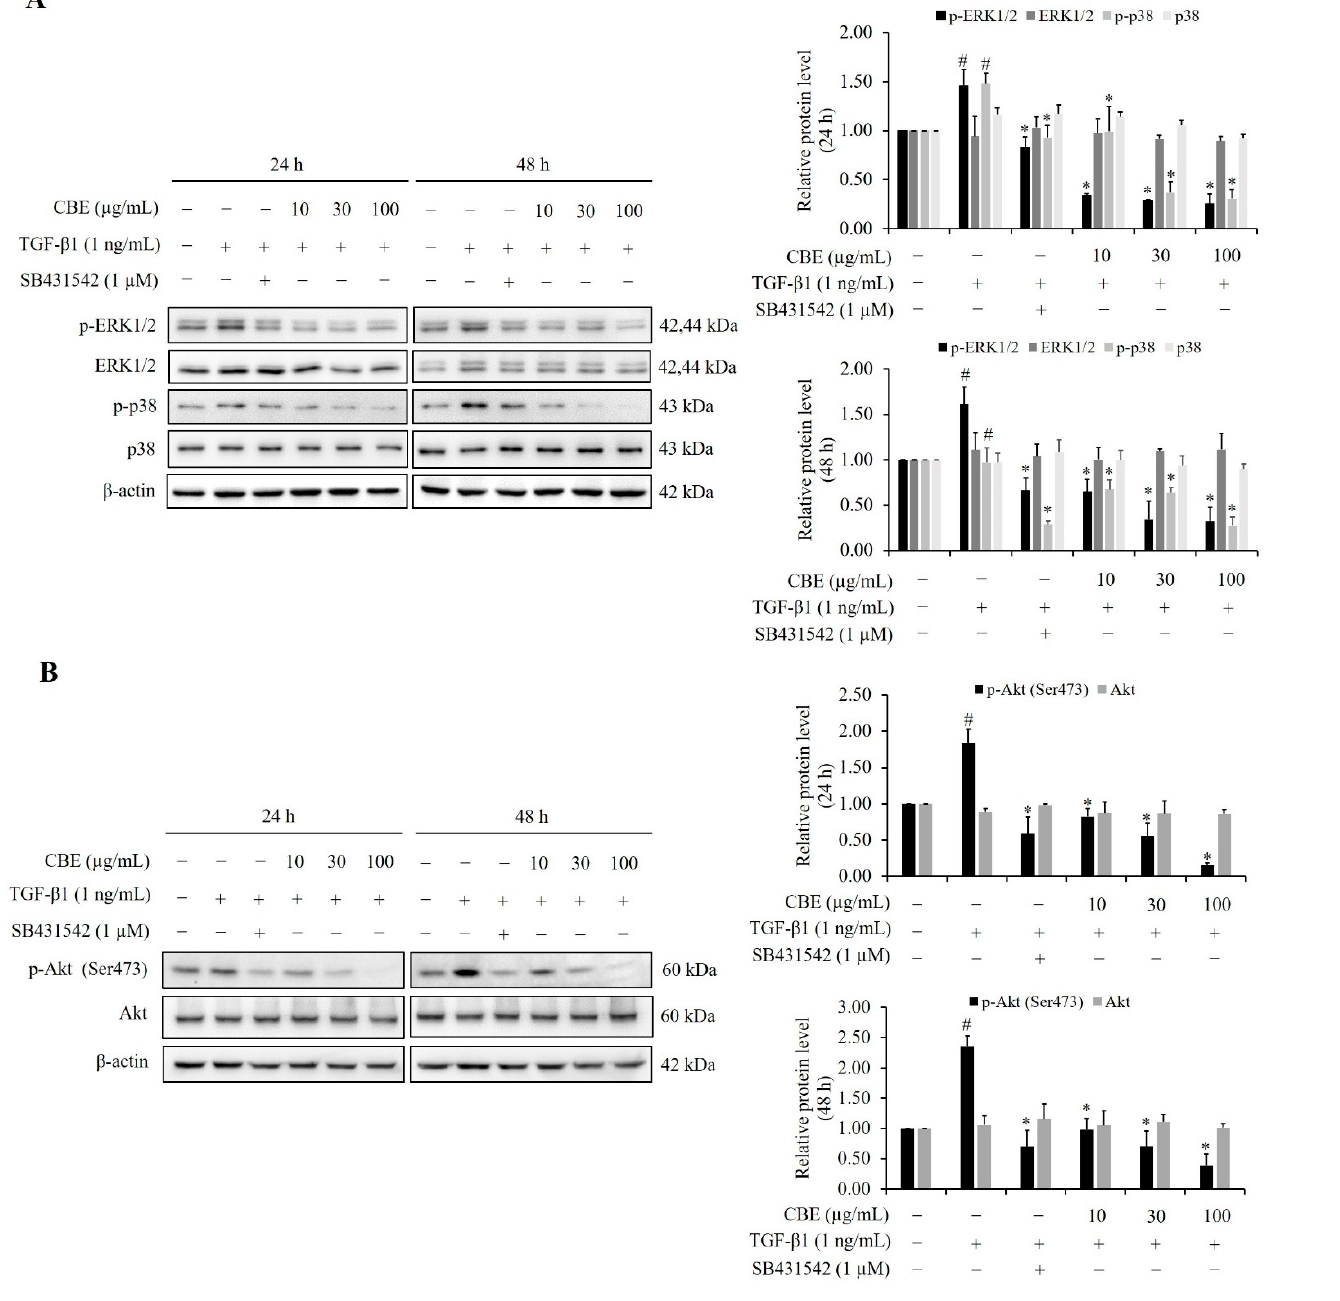
Figure 8. Effect of CBE on TGF- β 1-induced EMT via Smad-independent signaling pathway in LoVo cells. Cells were pre-treated with 10, 30 and 100 μ g/mL of CBE and 1 μ M SB431542. After incubation, cells were treated with 1 ng/mL TGF- β 1 for an additional 24 and 48 h. ( A ) Western blot analysis of p-ERK1/2, ERK1/2, p-p38, and p38 the proteins of MAPK signaling pathway. ( B ) Western blot analysis of p-Akt (Ser473) and Akt, proteins of Akt signaling pathway. β -actin was used as an internal control. Data are mean values ± SD of three independent experiments ( n = 3). # p < 0.05 compared to the control group. * p < 0.05 compared to the TGF- β 1-treated group. CBE, Cinnamomum bejolghota extract; SD, standard deviation.